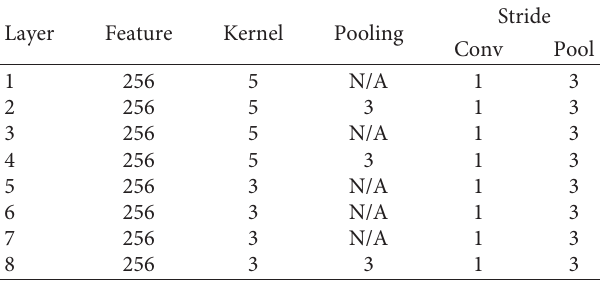
Table 2: The parameter setting of the convolutional neural